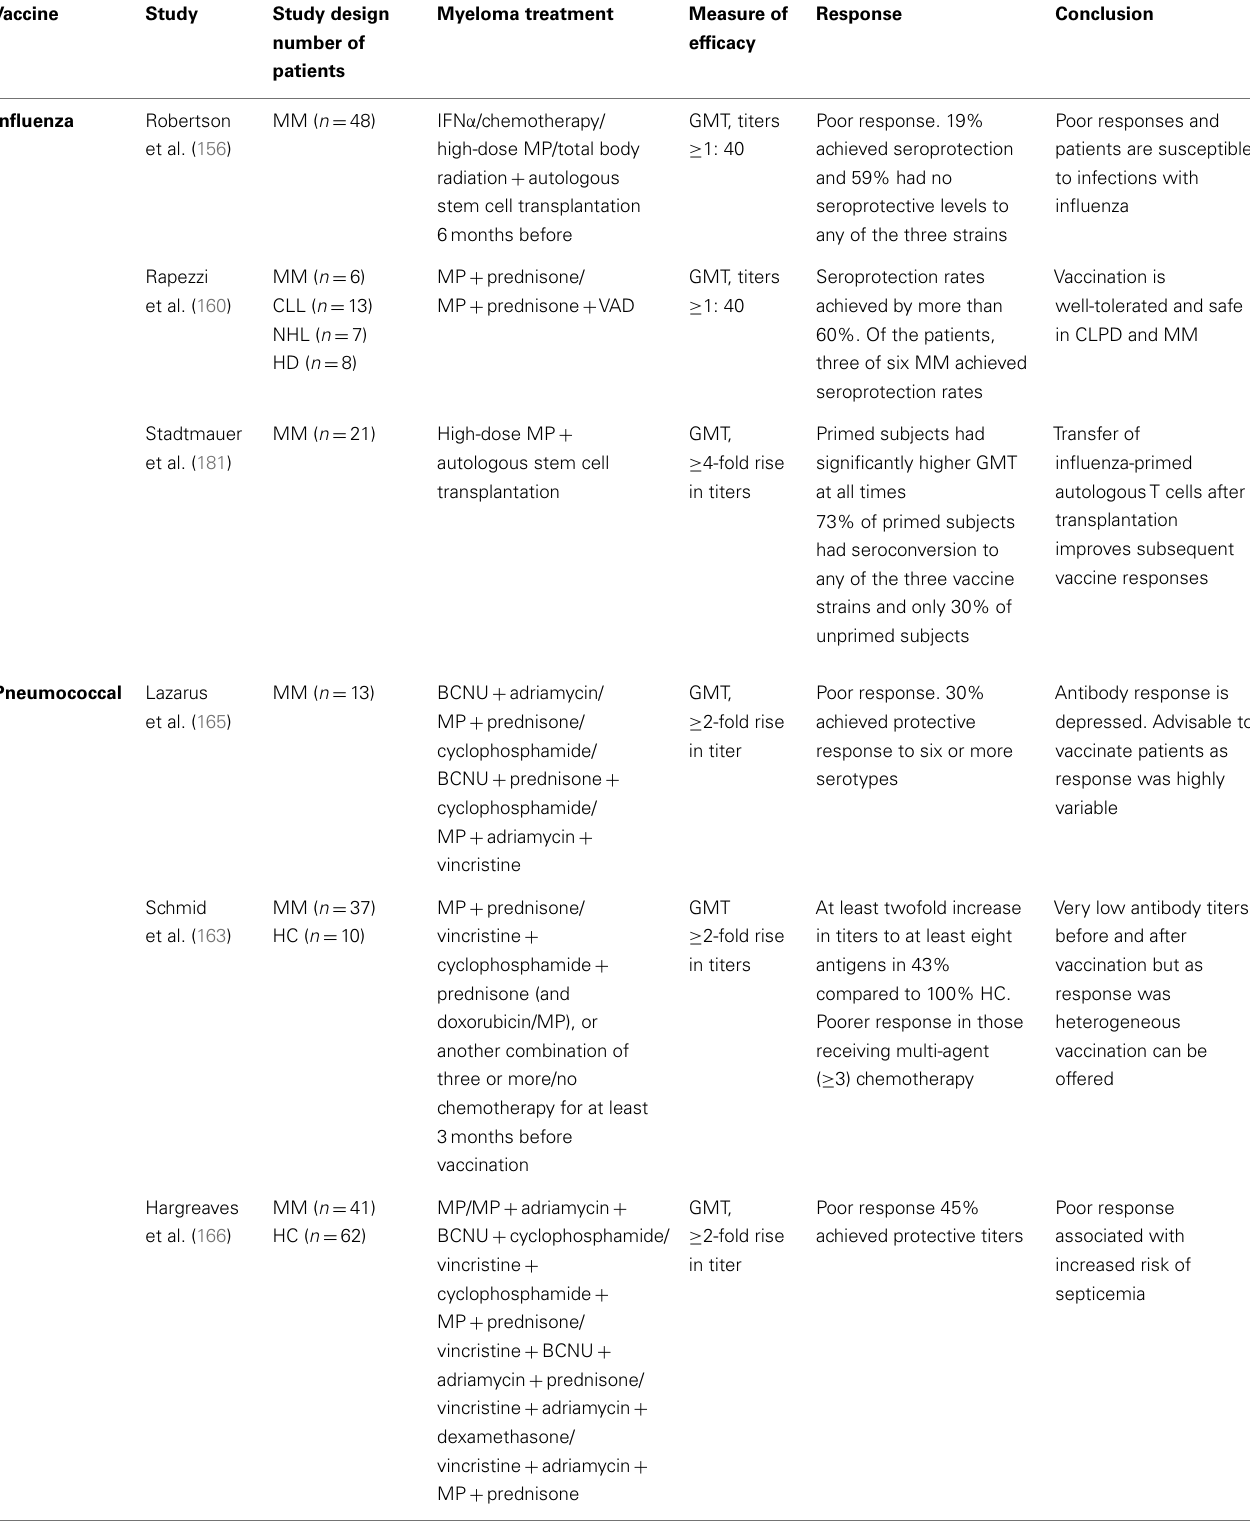
Table 1 | Results of studies of the efficacy of influenza, pneumococcal, and Hib vaccination in multiple myeloma